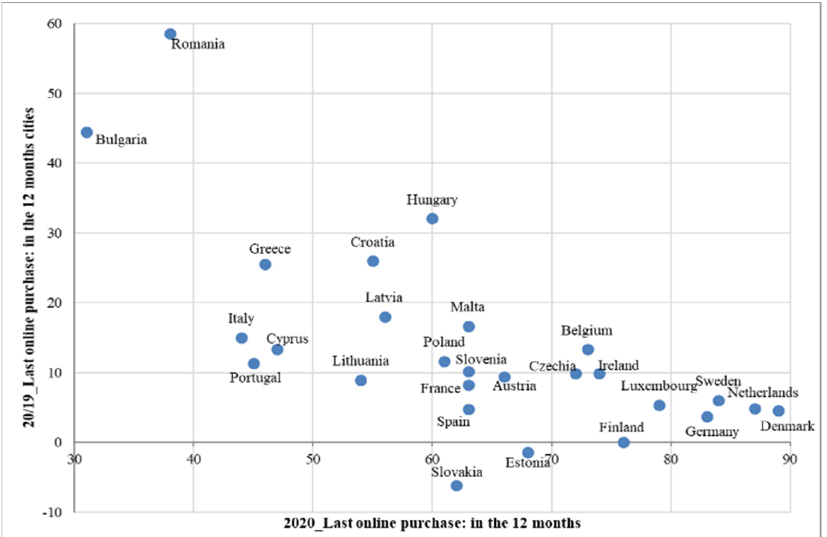
Figure 1. Last online purchases in the 12 months vs. dynamic in last purchases in the last 12 months across European countries in 2020 vs. 2019. Source data: own representation based on Eurostat data, 2020.